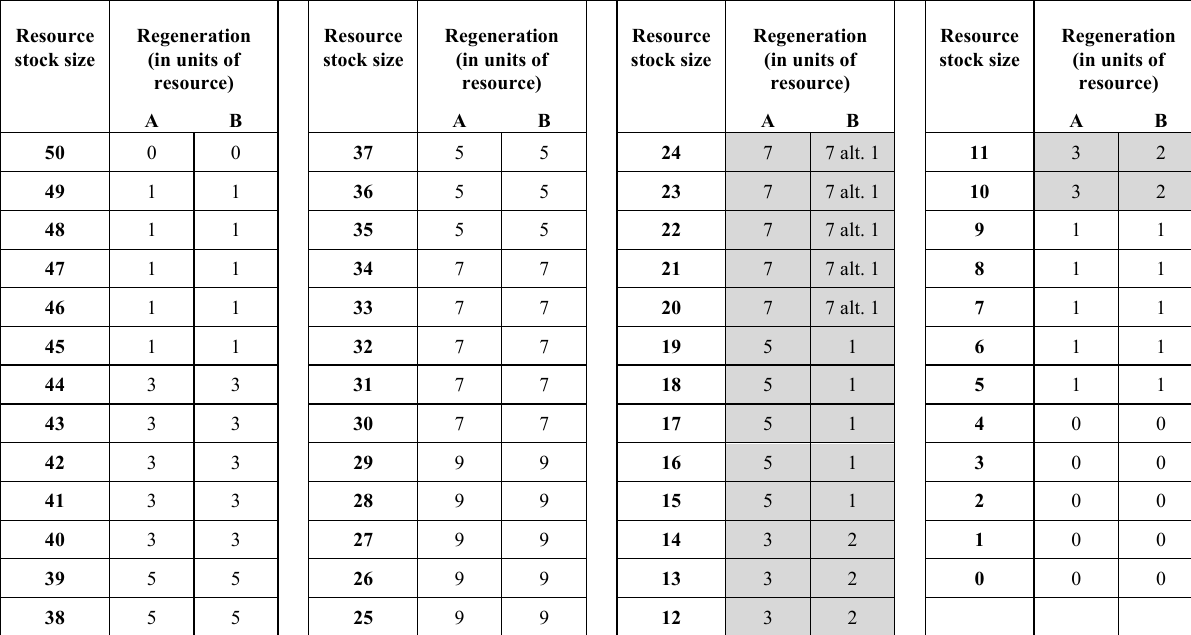
Table 1: Resource dynamics of scenario A and scenario